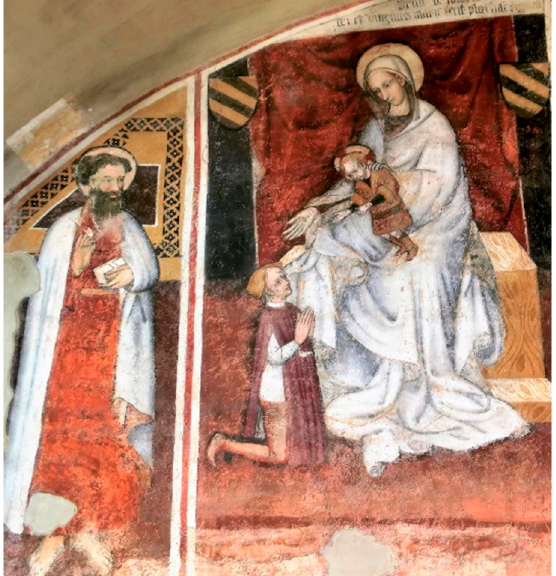
Figure 3. Virgin and Child underneath the dedication to the patron. Santa Maria Assunta Parish Church (Macello, Piedmont). Aymo Duce and collaborators, circa 1429 (photograph courtesy of Fabrizio Basagni-chieseromaniche.it).